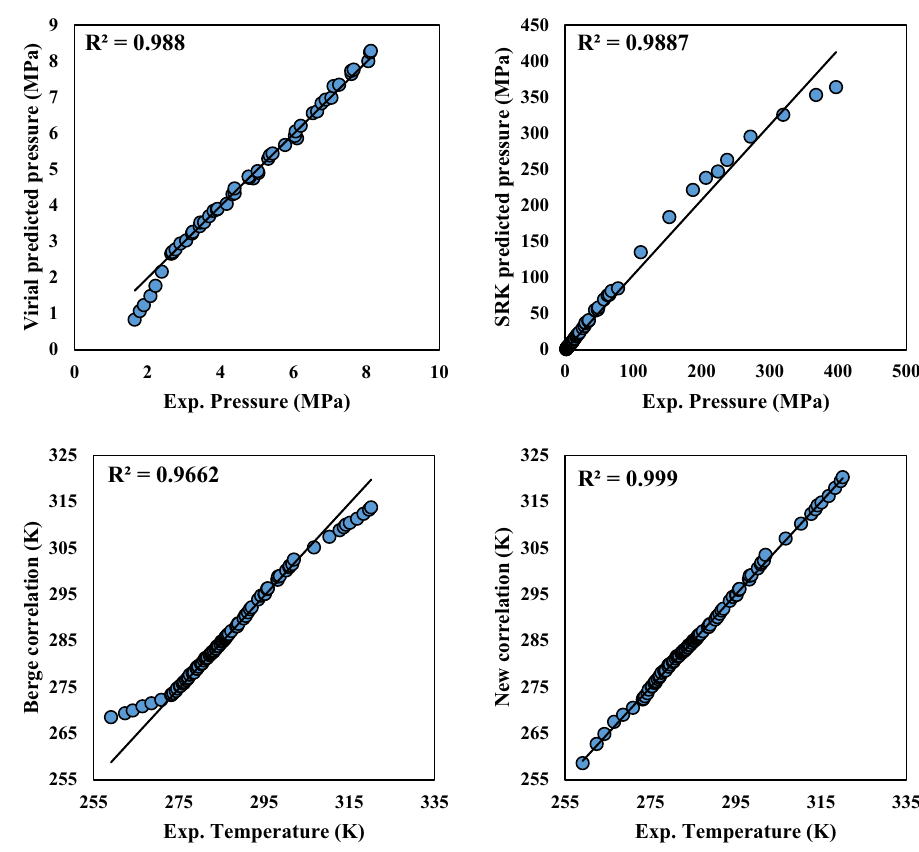
Fig. 8 Scattered diagrams of the best predicting methods